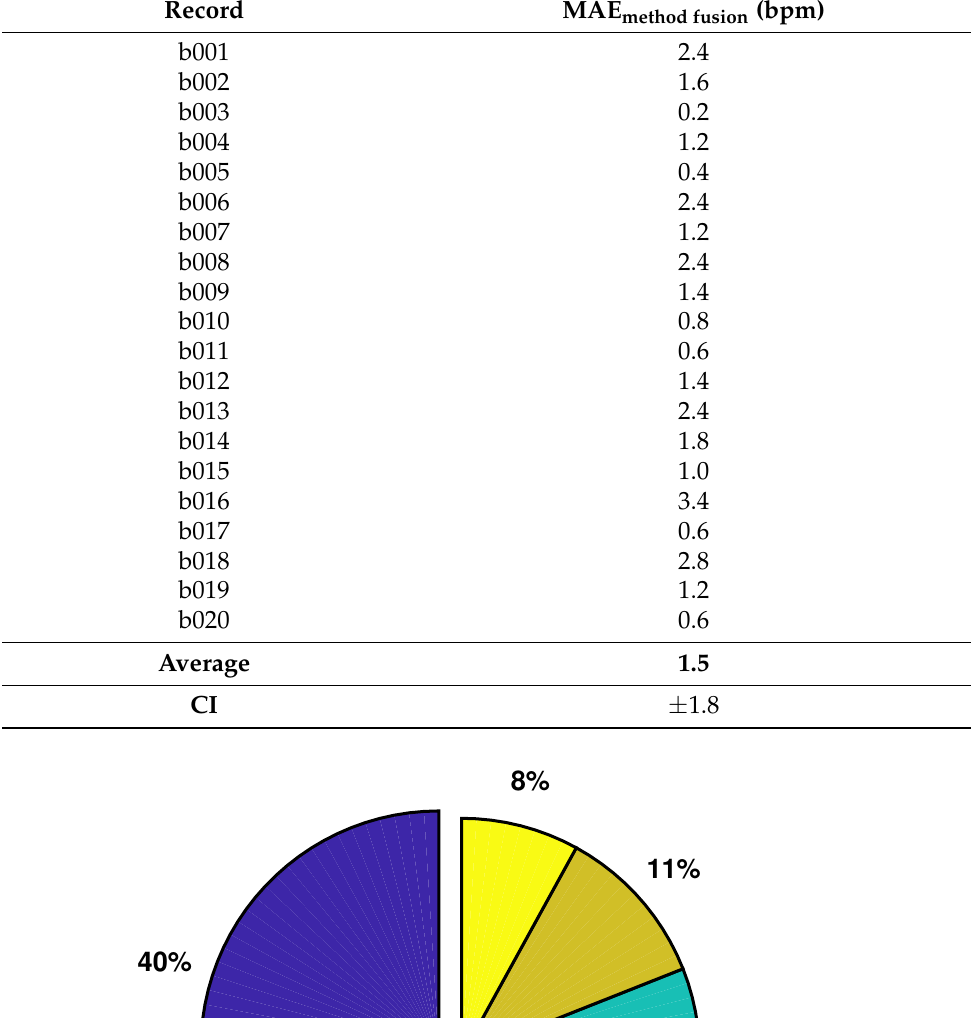
Table 7. Method Fusion performance.